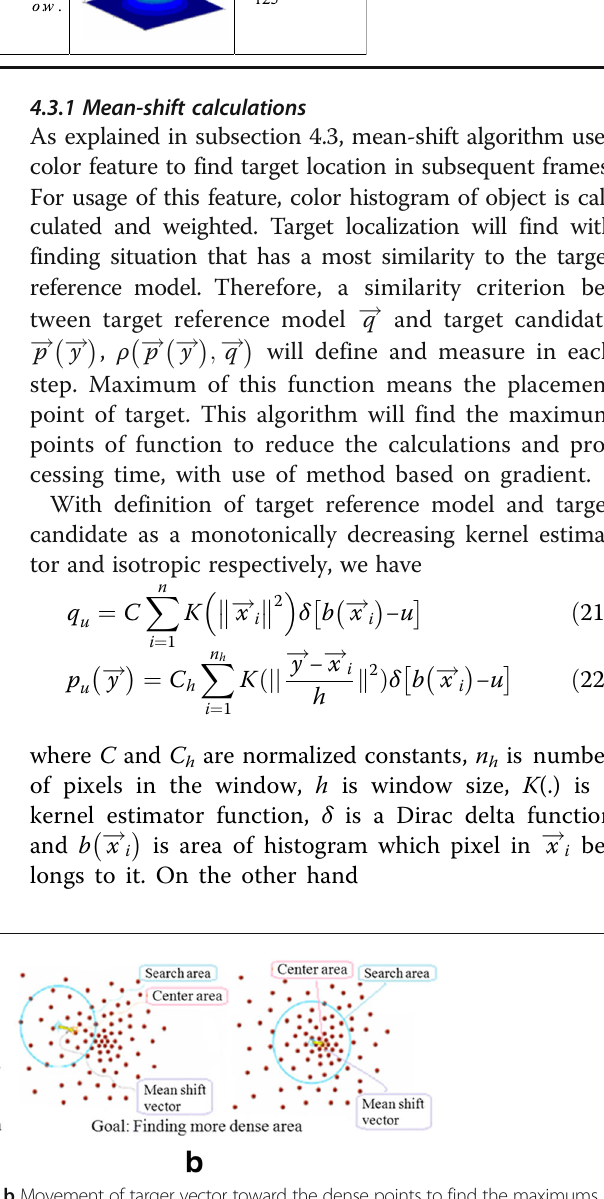
Fig. 6 a Correspondance of more dense points with higher points of PDF. b Movement of targer vector toward the dense points to find the